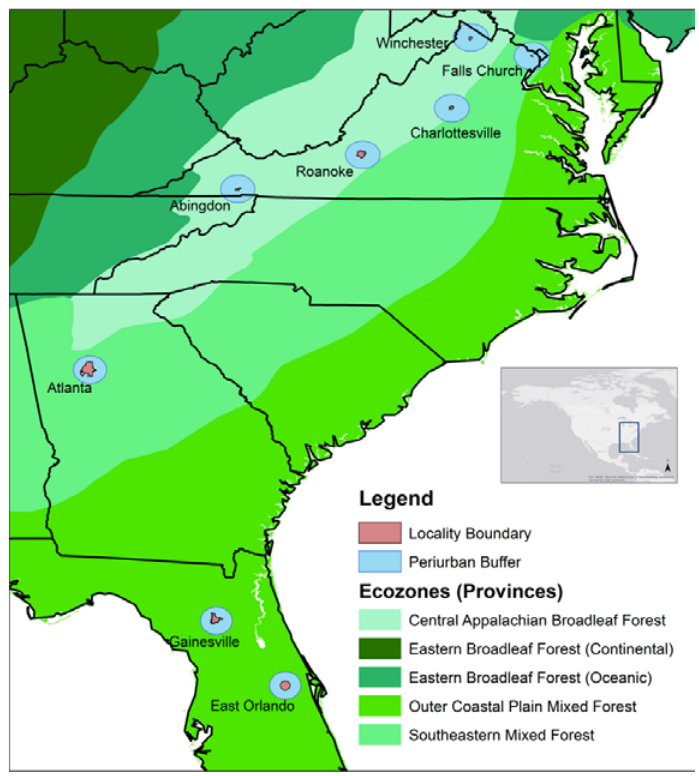
Figure 1. Eight urban forest locations sampled in the southeastern United States (SE US). Inset map shows where this region is relative to North America.